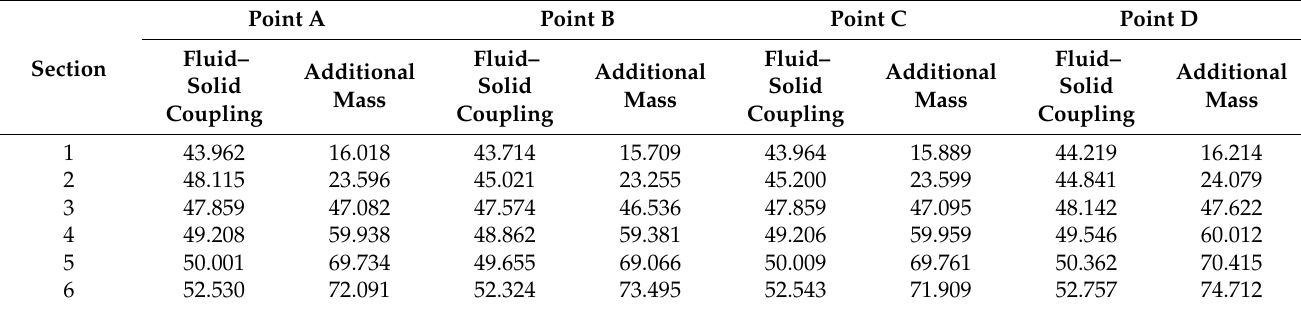
Table 5. Peak of displacement response of different pipeline cross-sections (unit: m) – right